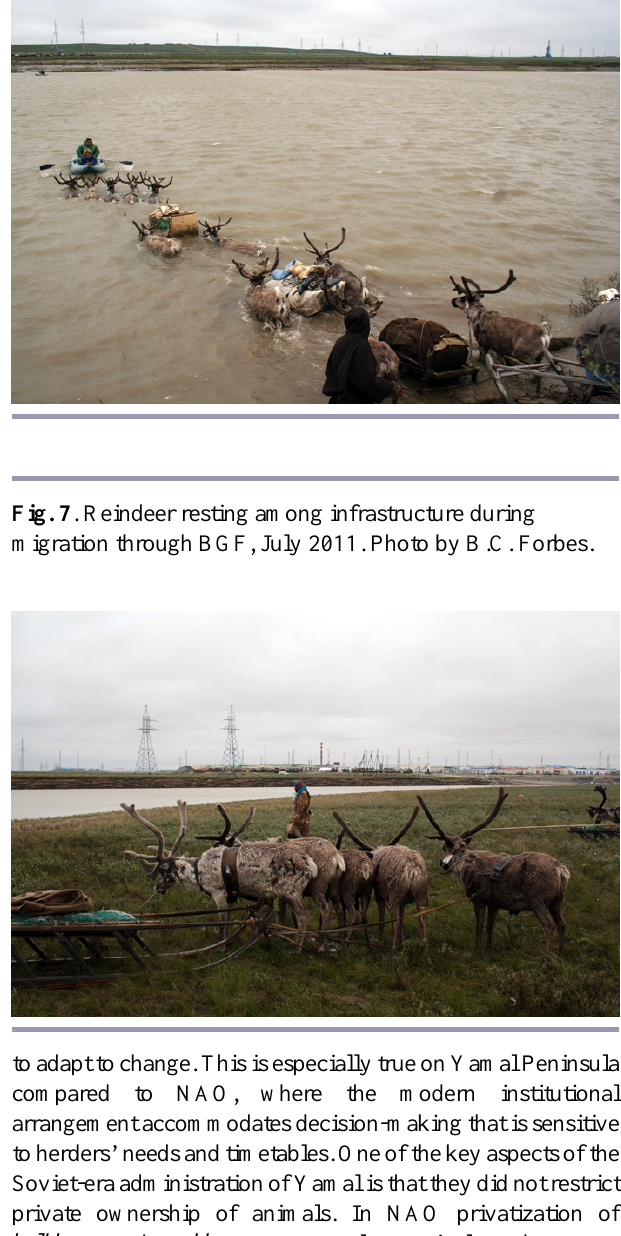
Fig. 6 . Part of a caravan of draught animals from a large brigade crossing the Se-yakha River in the midst of the Bovanenkovo Gas Field (BGF), July 2011. Photo by B.C. Forbes.